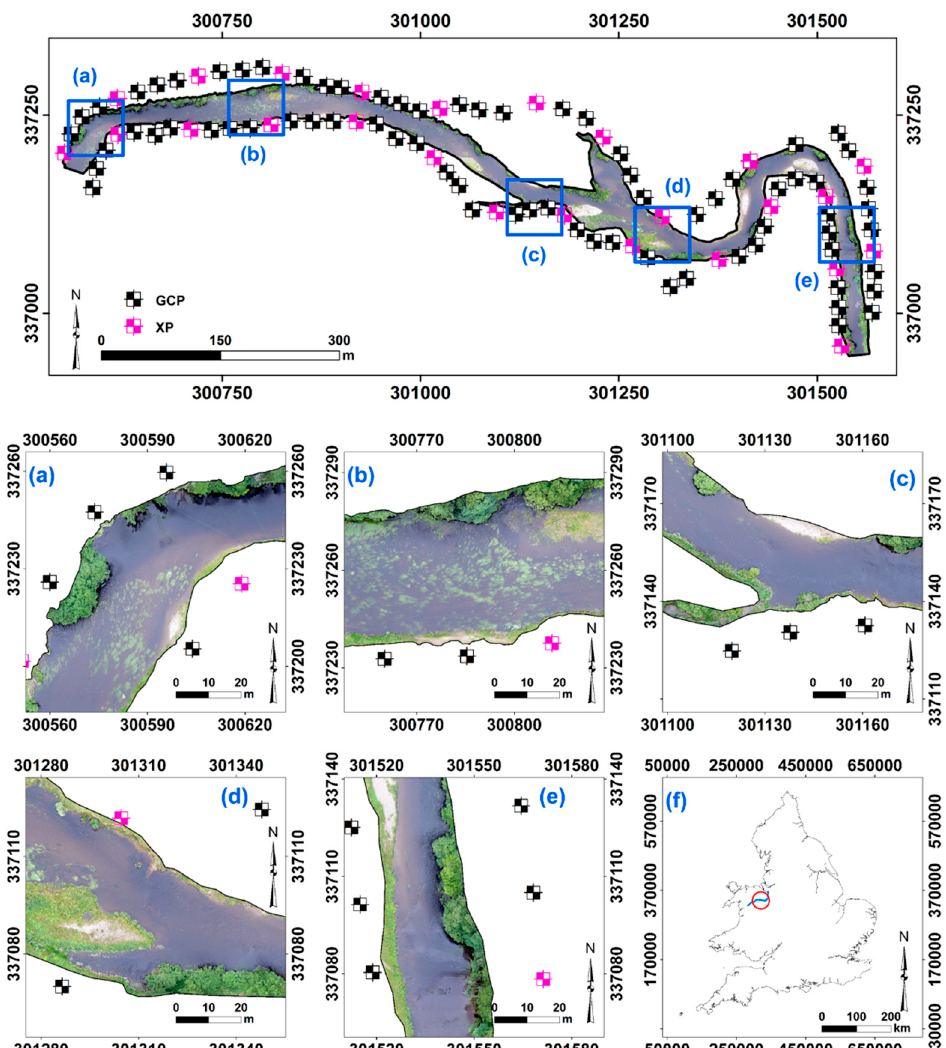
Figure 1. Site study area along the river Dee, near Bala (UK) with Ground Control Points (GCPs) and Check Points (XPs) distributed equidistantly along the 1.4 km reach. The close up views ( a – e ) show the diversity of hydromorphological features within the reach; The map of England and Wales ( f ) shows the location of the river Dee and highlights the case study area.